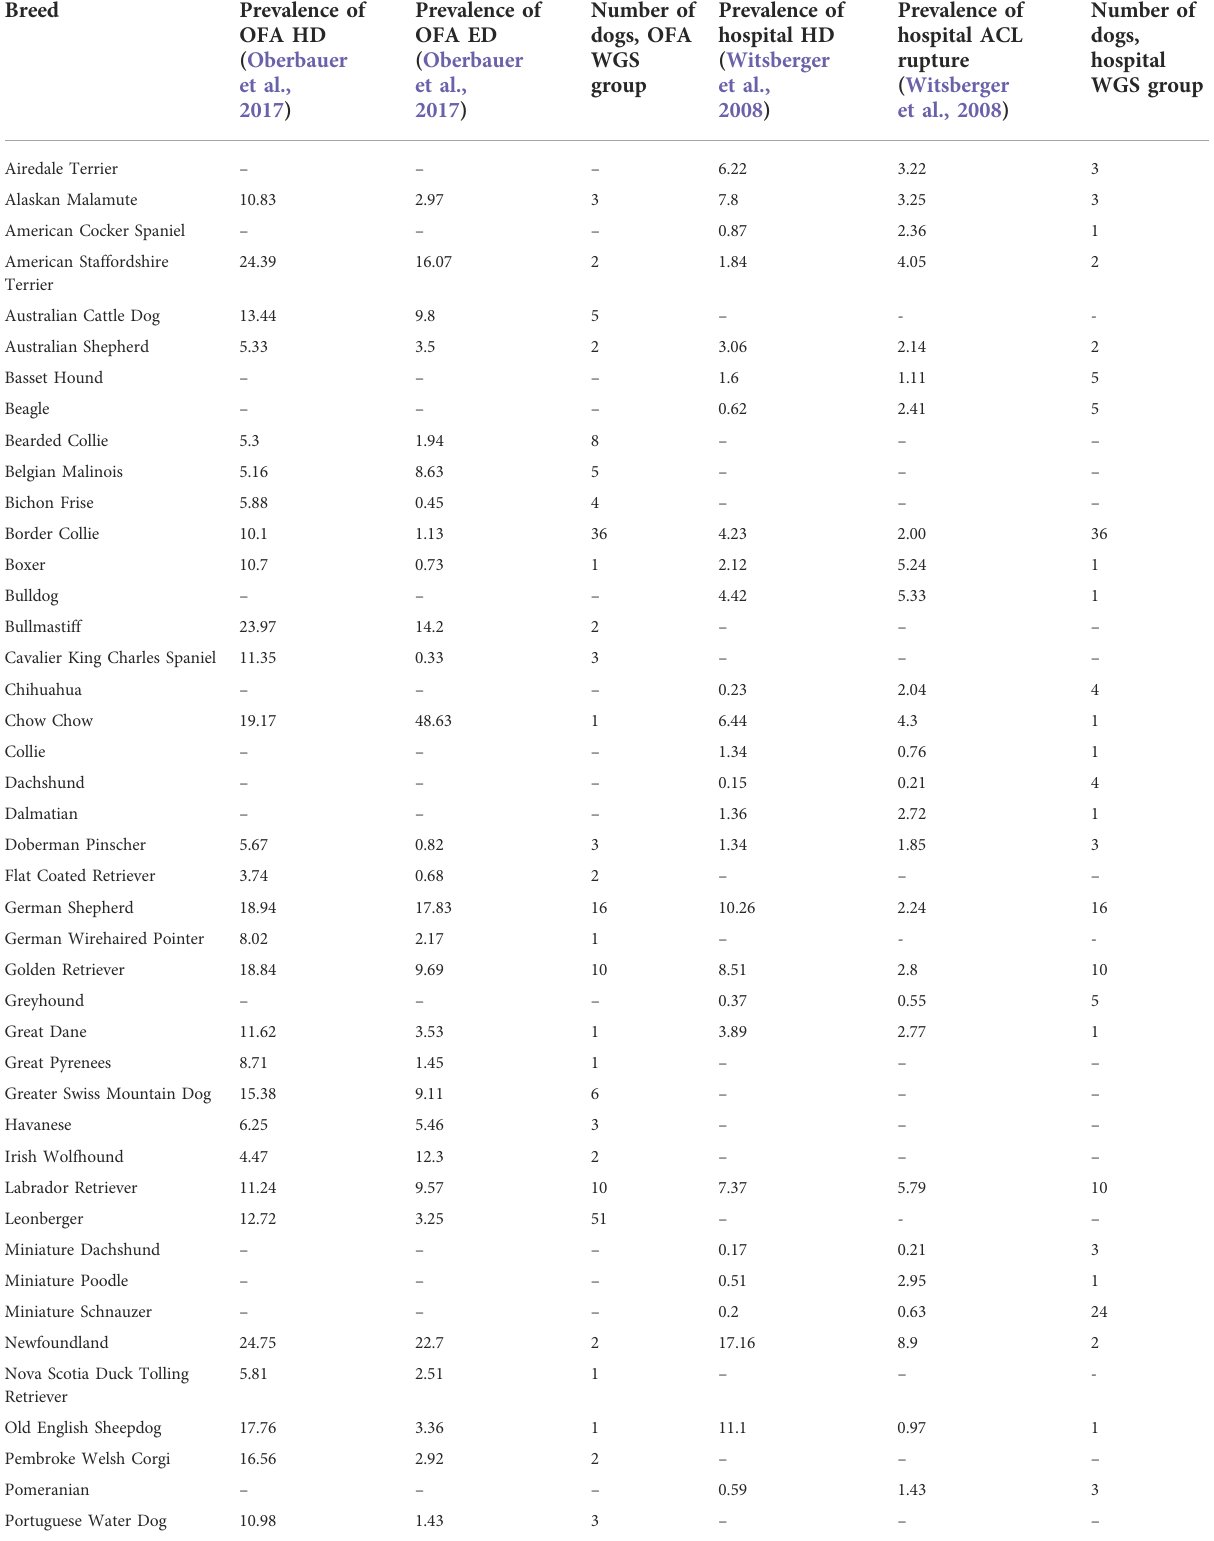
TABLE 1 Breed phenotypes for hip dysplasia, elbow dysplasia, and anterior cruciate ligament rupture. Breed